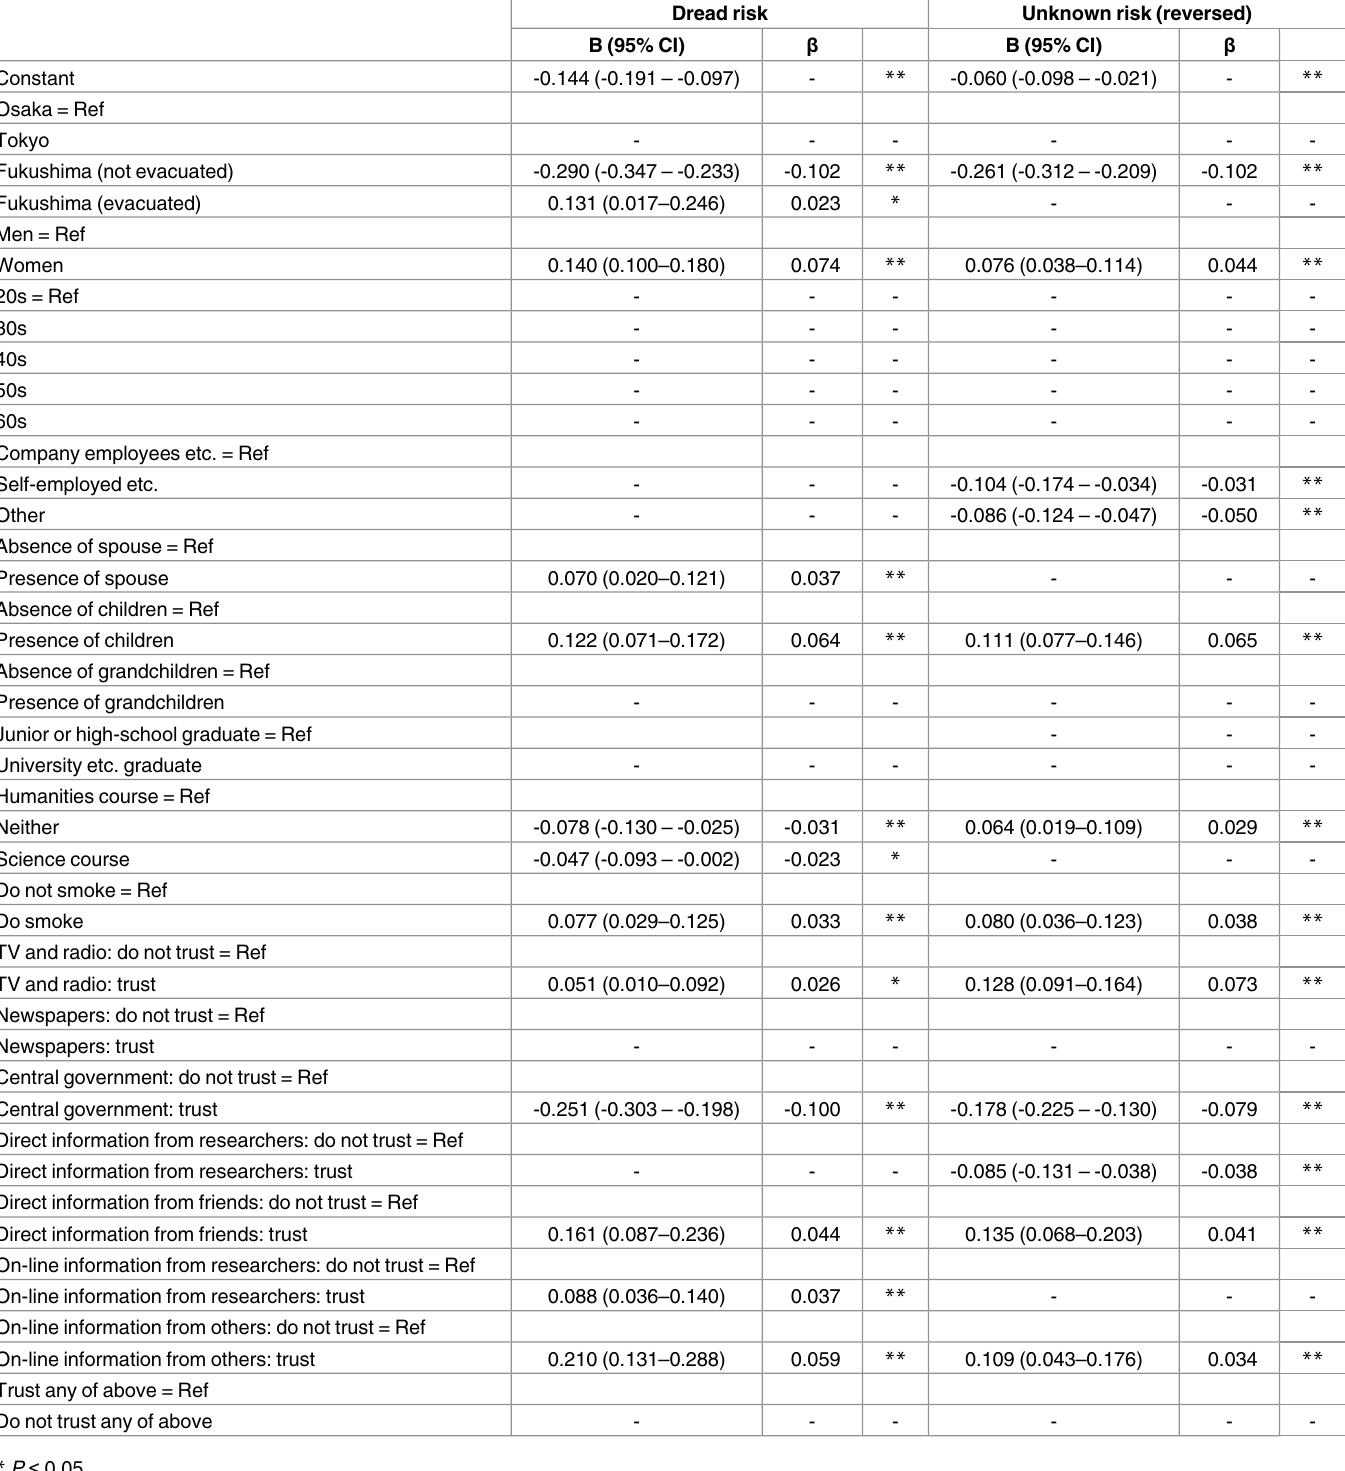
Table 4. Regression coefficients for perception of radiation risk. B: unstandardized regressioncoefficient; CI: confidential interval; β : standardized par- tial